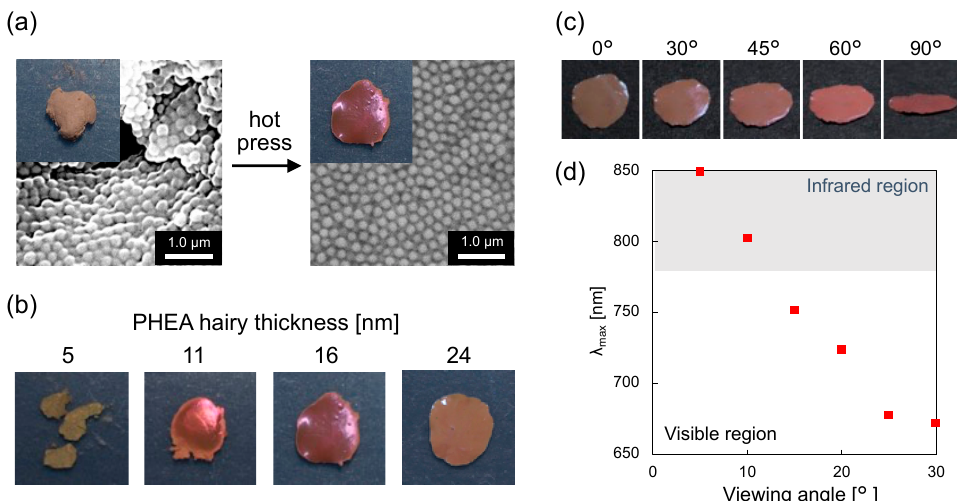
Figure 5. ( a ) SEM images of the freeze-dried samples of CeO 2 @PDA@PHEA(16) before and after hot- pressing. The insets show photographs of the samples. ( b ) Photographs of the structural color films composed of CeO 2 @PDA@PHEA particles with different PHEA hairy thicknesses. ( c ) Photographs and ( d ) λ max for the reflection peaks for the structural color film composed of CeO 2 @PDA@PHEA(24) particles viewed from different viewing angles.